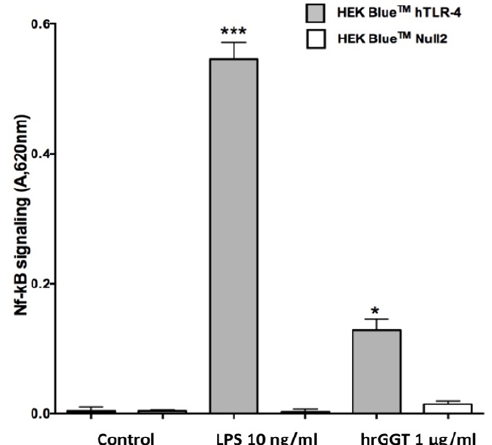
Figure 11. NF- κ B quantification in HEK-Blue hTLR4 and HEK-Blue Null2 cells stimulated with 1 µg/mL hrGGT for 18 h at 37 °C and at an atmosphere of 5% CO 2 . hrGGT induced NF- κ B in HEK-Blue hTLR4 cells, but not in HEK-Blue Null2 cells which lacked TLR4 receptor. LPS (10 ng/mL), the selective agonist of TLR4s, was used as a positive control. *** p < 0.001 vs. control; * p < 0.05 vs. control. Data are presented as mean ± SEM ( n = 3). The relative expression level of SEAP (directly proportional to N κ -kB activity) was determined spectrophotometrically at 620 nm.